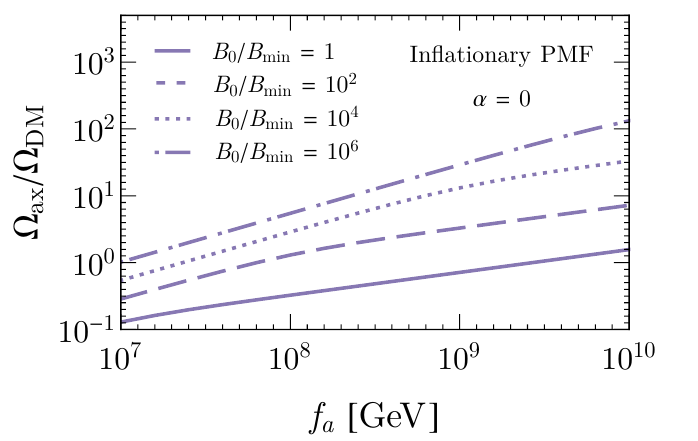
Ω . Left : α = 1 / 3 Right : α = 3 / 5 . ax / DM